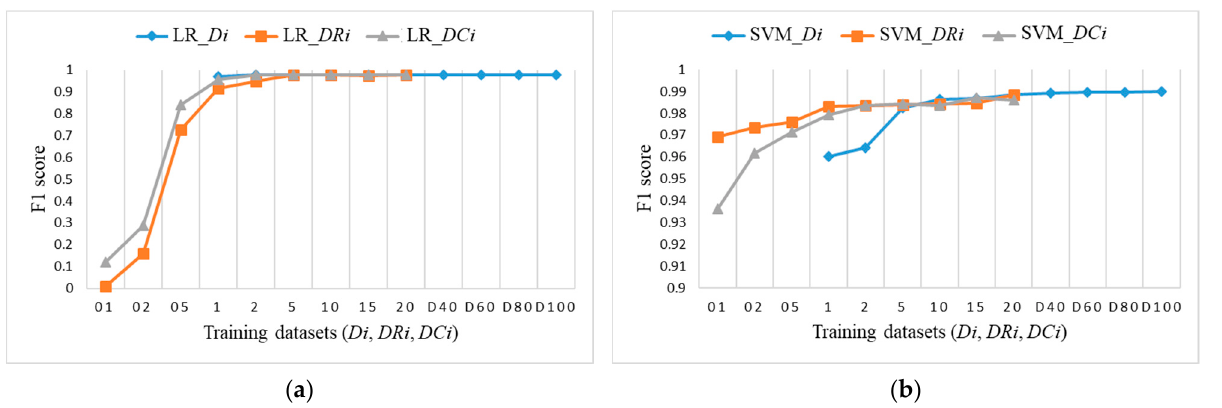
Figure 18. F1 score on test dataset for training datasets Di , DRi , DCi : ( a ) DT; ( b ) RF.